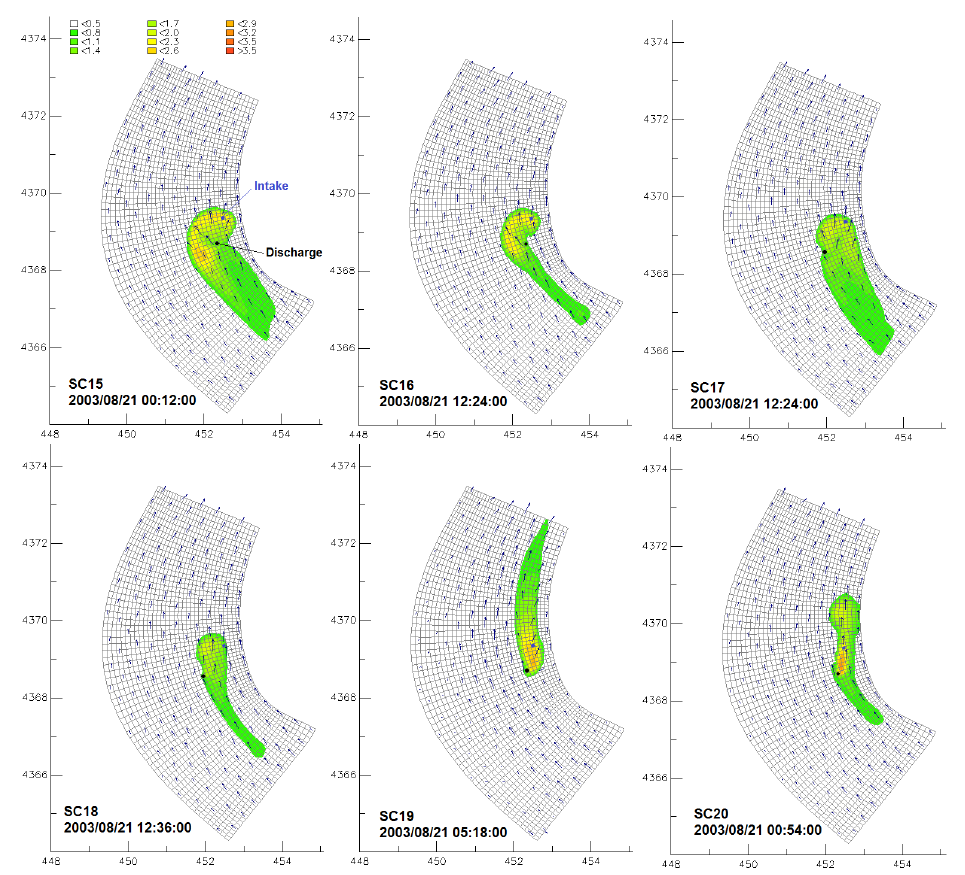
Figure 13. Maximum excess temperature: Scenarios 15 through